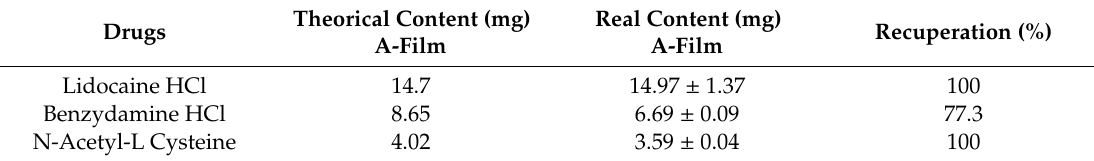
Table 5. The content of drug expected in A-film, real content, and percent of